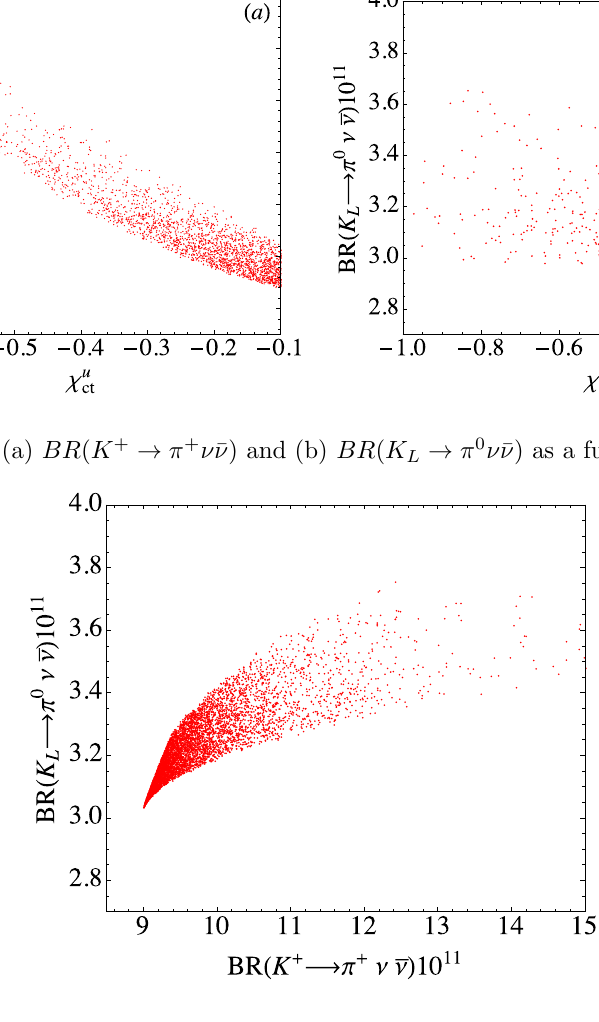
Figure 10 . Correlation between BR ( K +